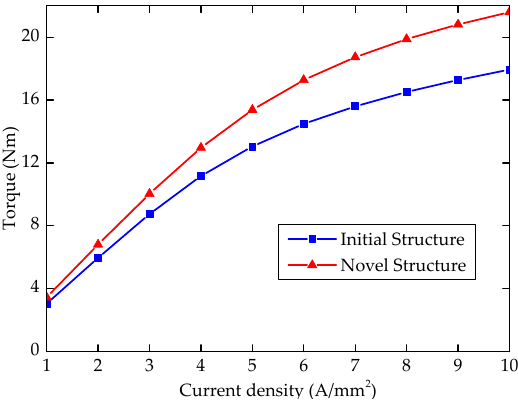
Figure 9. Average torque waveforms versus the current density. Energies 2020 , 13 , x FOR PEER REVIEW